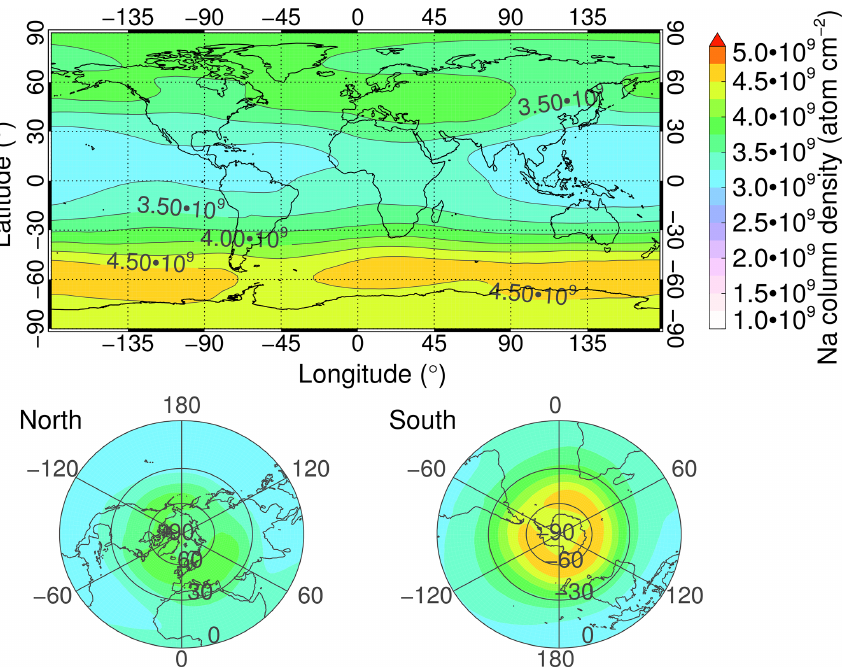
Figure 6. Global geographical distribution of the annual mean WACCM simulated Na column number density during the period 2004 to